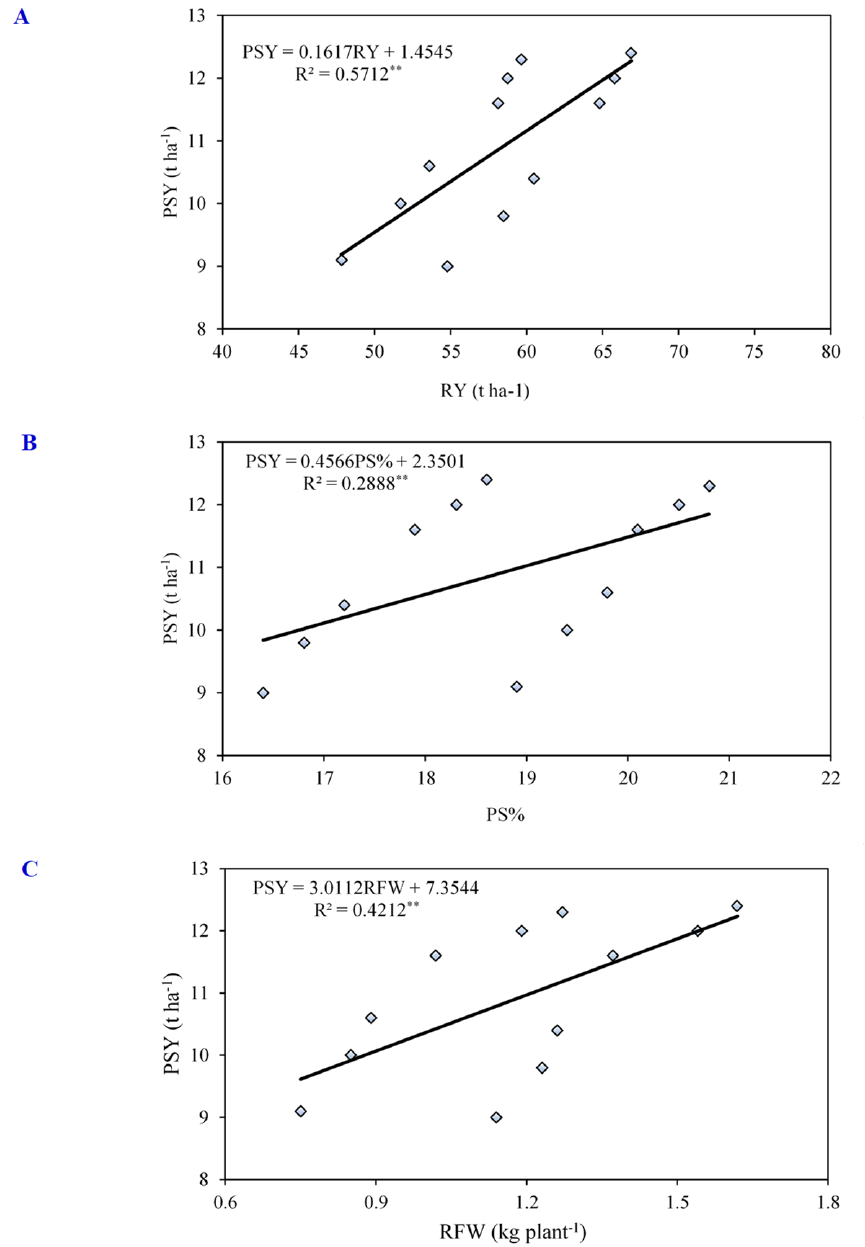
Figure 2. Functional relation between the pure sugar yield (PSY) and root yield (RY; A ) and pure sugar concentration (PS%; B ) and root fresh weight (RFW; C ) by data of V × K × Zn interaction (data pooled over both seasons) under saline soil (EC e = 8.60 dS m − 1 ) conditions. ** refer to significant difference at p ≤ 0.01.